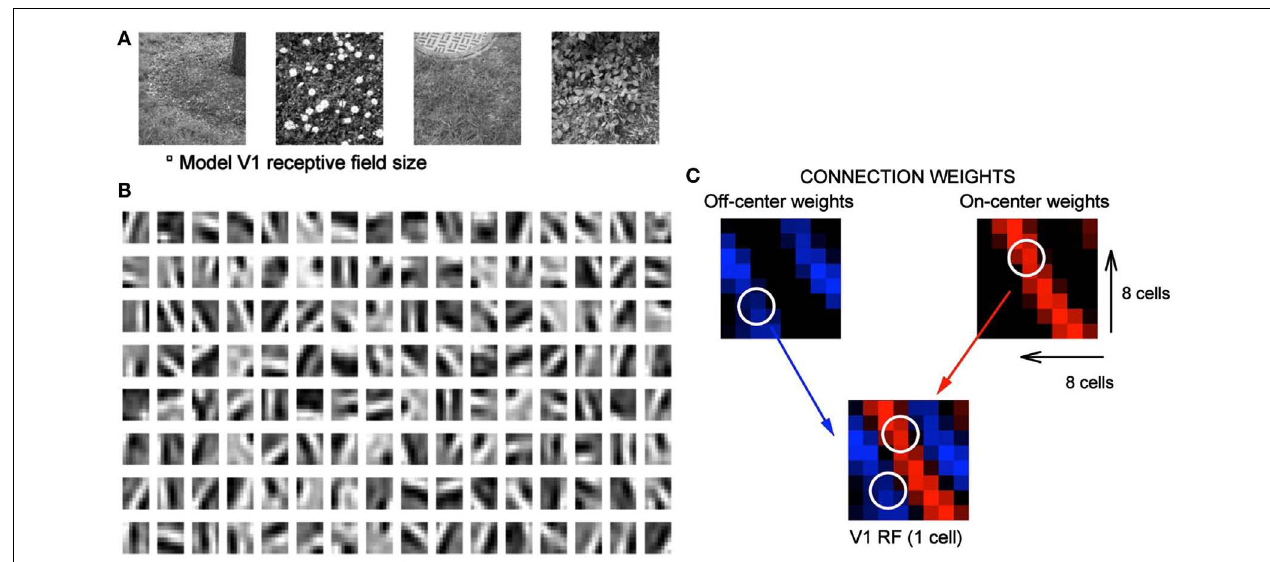
Black depicts off-regions in the modelV1 receptive field, white depicts on-regions. (C) A detail from the feed forward connections in the model making the connections of different sign explicit. Blue denotes OFF-center connections and red denotes ON-center